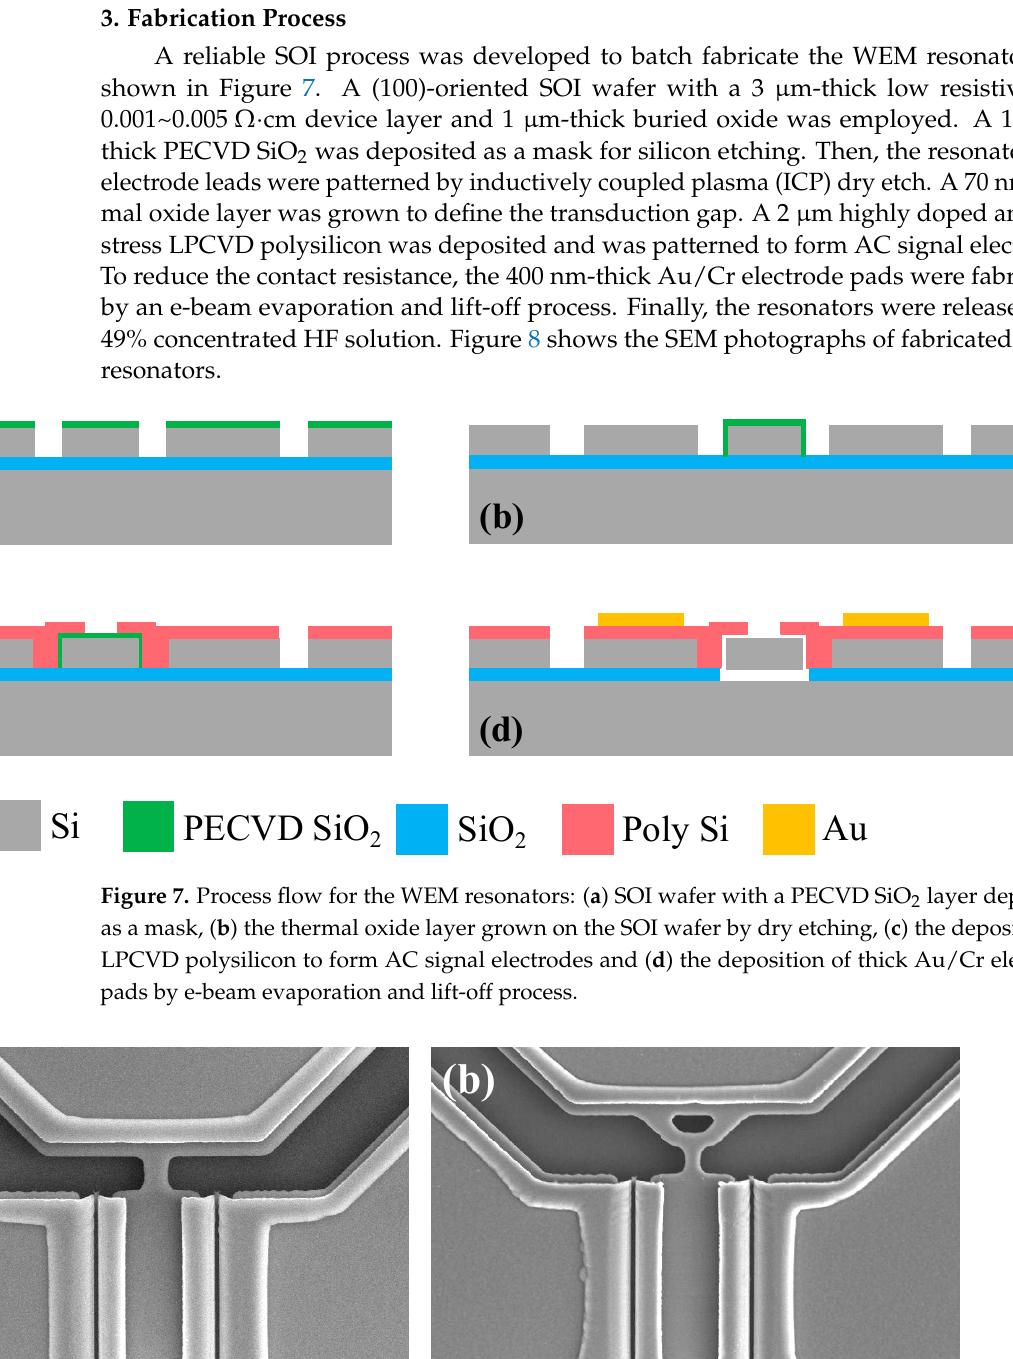
Figure 6. The frequency dependence of Q AKE .